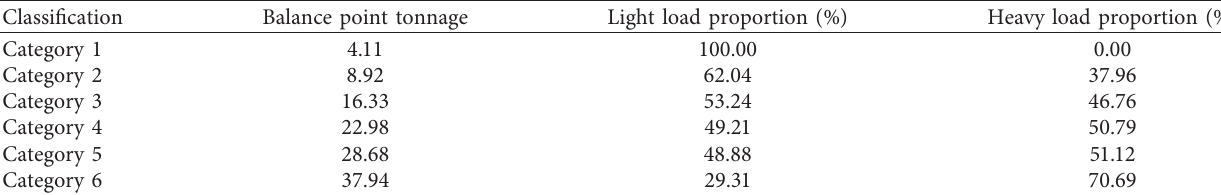
Table 4: Distribution of light and heavy loads in freeway network.